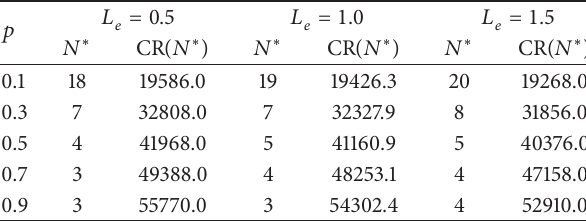
Table 6: Sensitivity analysis for 𝐿 𝑒